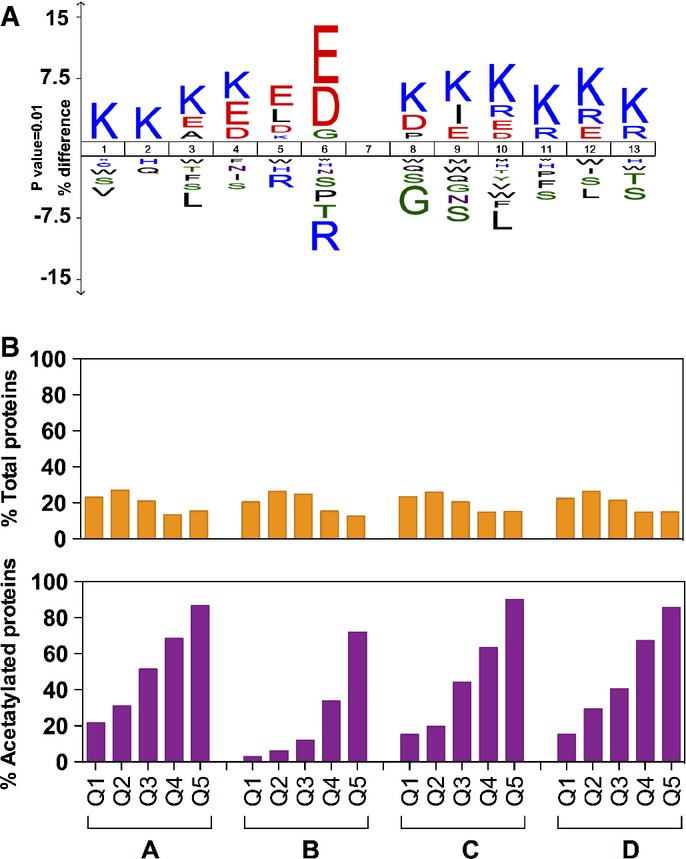
Analysis of acetylated proteins: acetylation motif and effect of protein abundance on
acetylationSequence motif surrounding acetylated lysines. Logo was created using the Icelogo software
package. All acetylated peptides found with an acetyl (K) probability higher than 0.9 and a cutoff
P-value < 0.01 were used.Frequency of protein acetylation detection as a function of protein abundance in the cell.
Proteins in whole-cell extract protein digests were analyzed by LC-MS. Quantified proteins were
sorted as a function of their relative abundance into five quantiles Q1–Q5. The less abundant
proteins belong to Q1, and the more abundant ones to Q5. This analysis was performed for each
experimental replicate and in all conditions assayed in this study: A, acetate cultures; B,
chemostat cultures; C, glucose batch cultures exponential phase; D, glucose batch cultures
stationary phase (n = 4 per condition). Upper bar plot: Orange bars
represent the percentage of total proteins detected belonging to each quantile at each condition
(n = 4). Lower bar plot: Purple bars represent the percentage of acetylated
proteins belonging to each protein quantile. Further information is detailed in the Supplementary
Materials and Methods.Source data are available online for this figure.